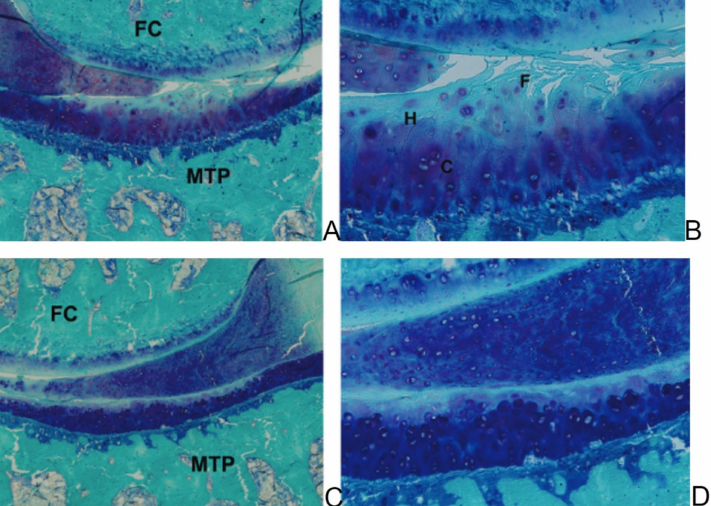
Figure 3. ( A , B ) Medial articular compartment of a DH guinea pigs of 21 months of age. High fibril- lation, reduced staining and cartilage thickness are observed. ( C , D ) Madial articular compartment of a DH guinea pigs of 21 months of age treated with PEMFs at 75 Hz. An increased cartilage preservation is much more evident and reduced fibrillation, increased PG content and normal cell distribution are observed. FC: femoral condyle, MTP: medial tibial plateau, H: Hypocellularity zone, C: clusters, F: fibrillation zone. Toluidine blue/Fast green staining. ( A , C ) 8 × of magnification; ( B , D ) 50 × of